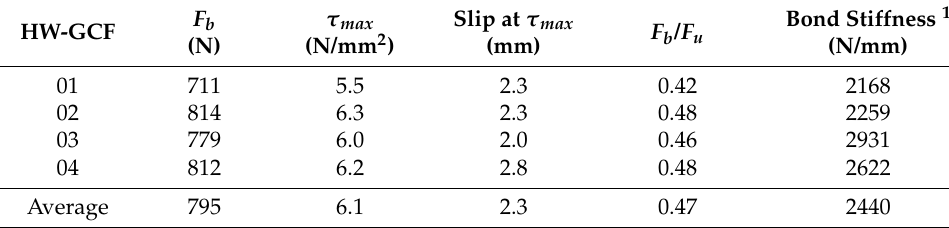
Table 3. Experimental results for the ‘HW-GCF’ systems under pull-out tests.